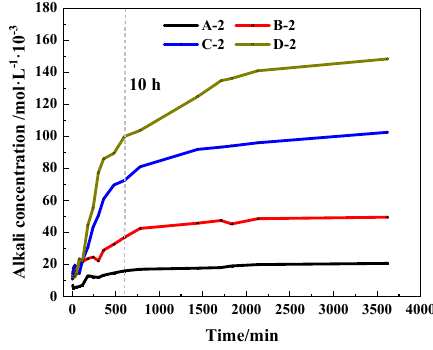
Figure 10. Release rate of alkaline ions under different doses of Na 2 CO 3.